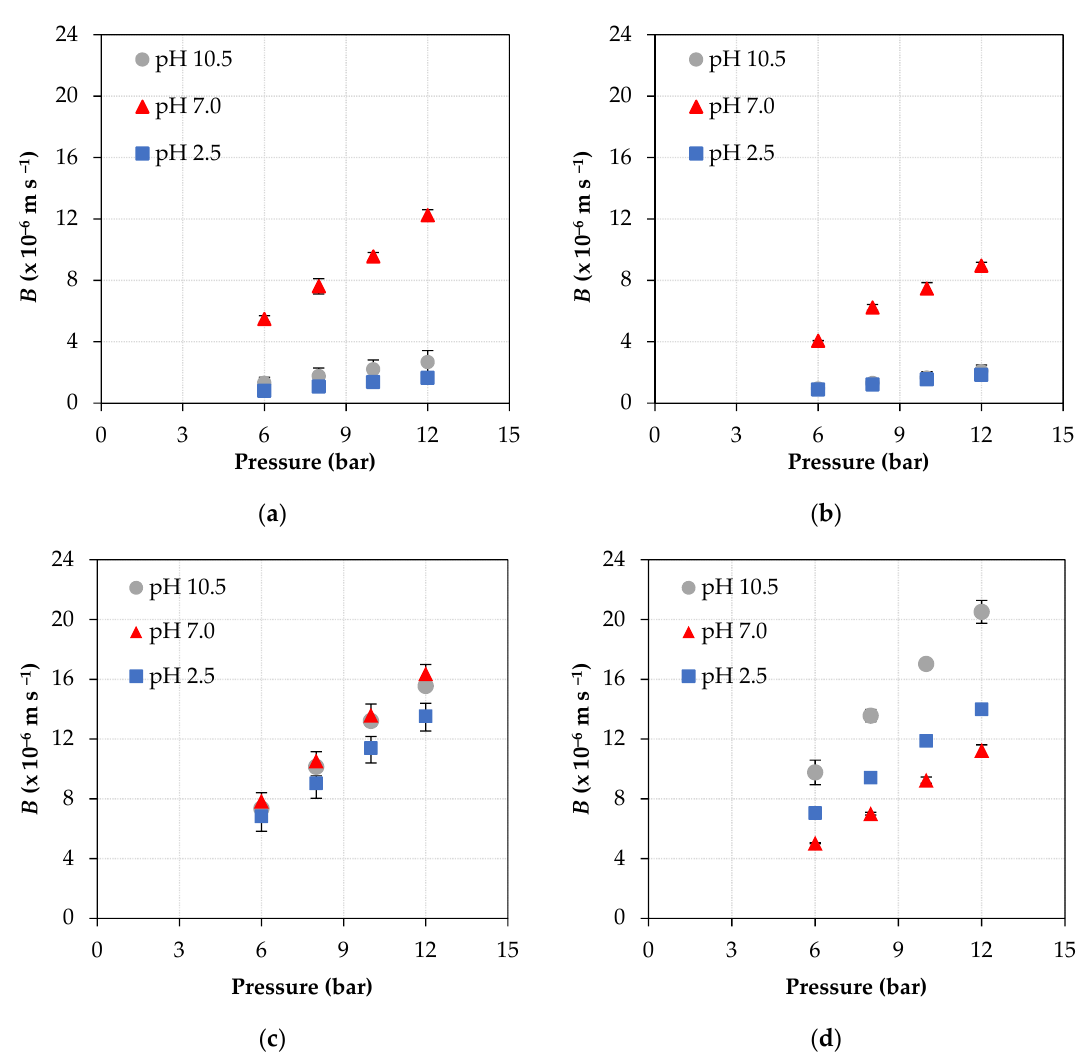
Figure 3. Variation of the B parameter as a function of pressure, at three pH conditions, with NF90 (top) and NF270 (bottom) membranes: ( a ), ( c ) feed solution containing 8 mg L − 1 ATN; ( b ), ( d ) feed solution containing 16 mg L − 1 ATN.